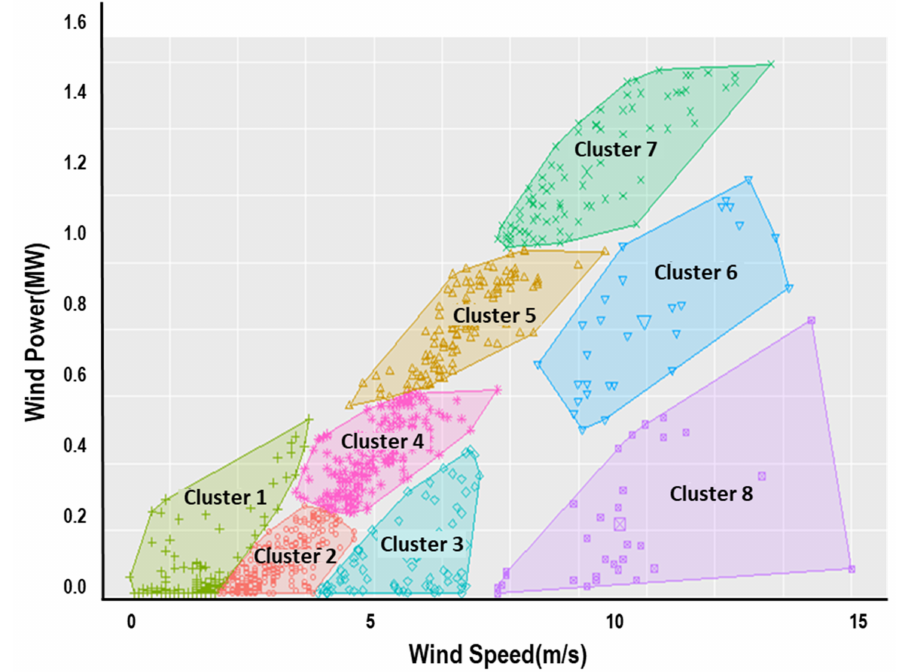
Figure 5. Results from K-Means Clustering.